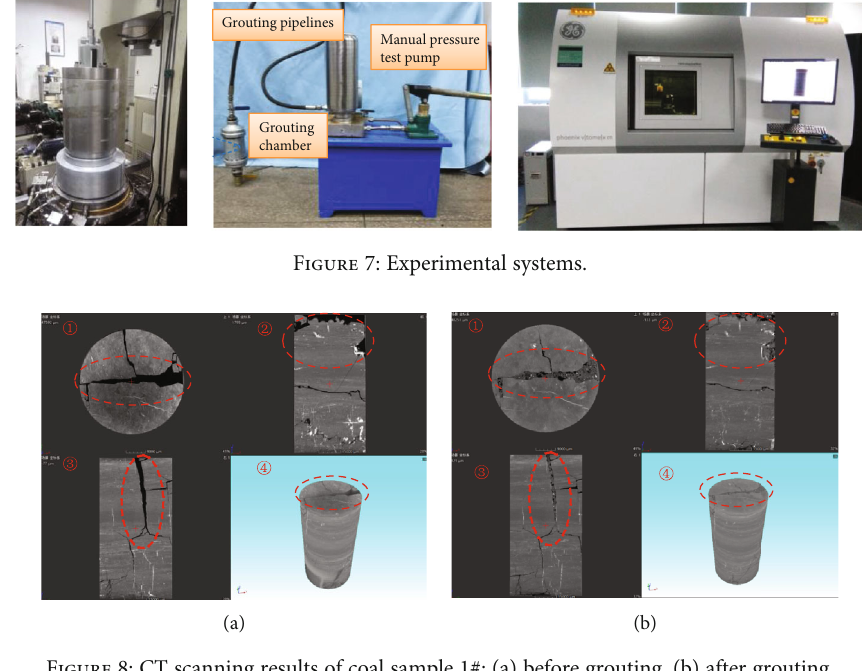
Figure 8: CT scanning results of coal sample 1#: (a) before grouting, (b) after